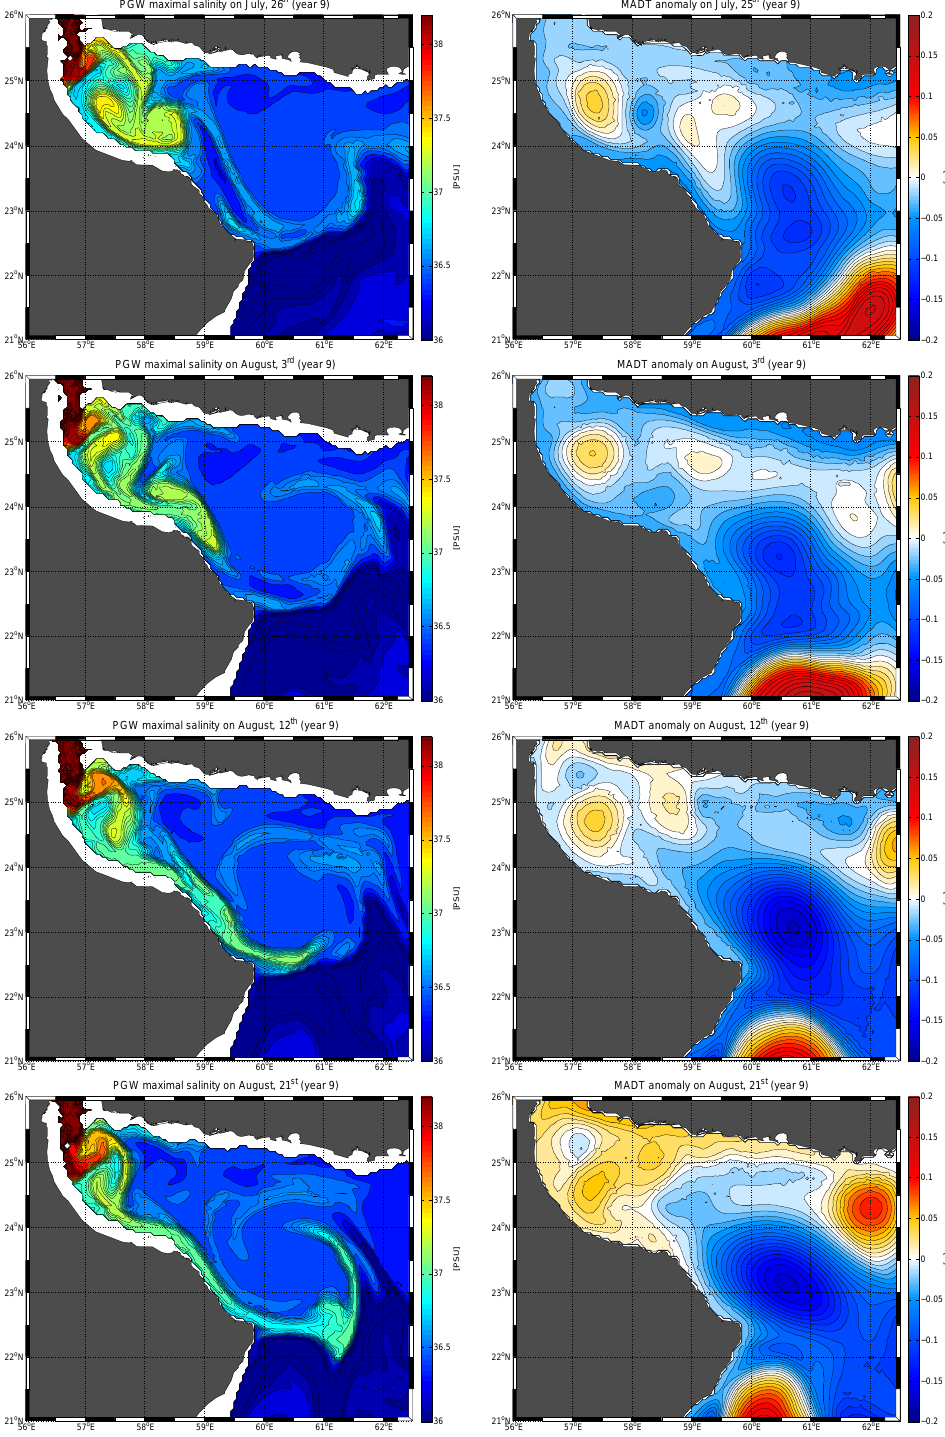
Figure 17. Evolution of the maximal PGW salinity (left) and MADT anomaly (right) during a pulse of PGW and an ejection of PGW at Ra’s Al Hadd in year 9 of the HYCOM simulation, on 25 July (first row), 3 August (second row), 12 August (third row) and 21 August (fourth